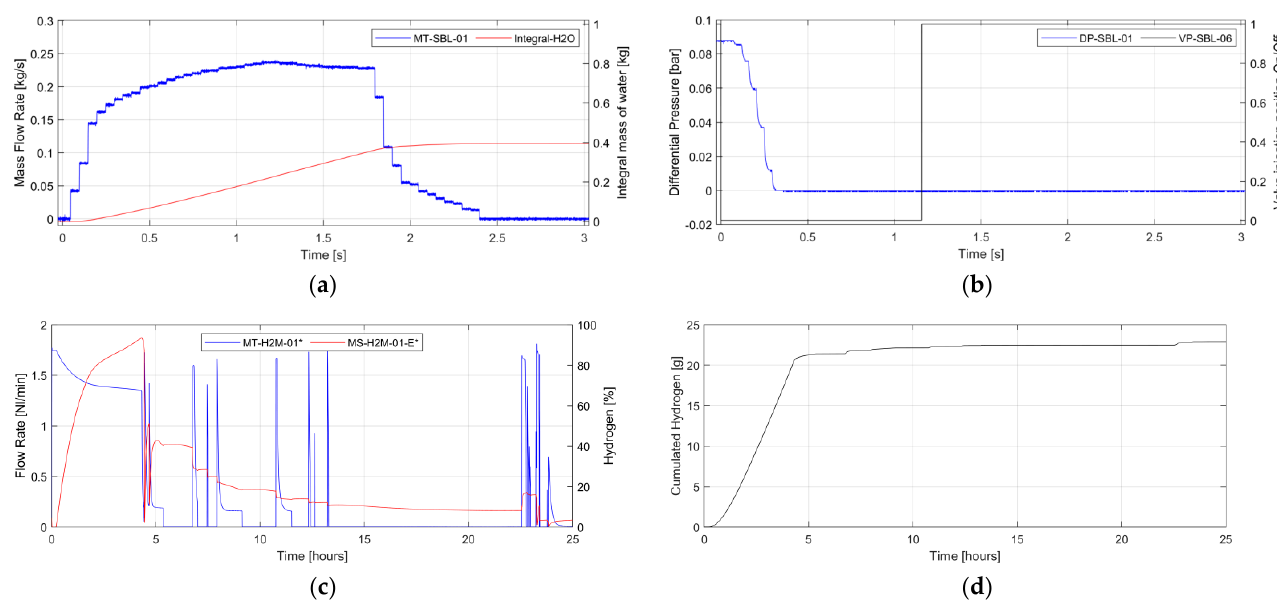
Figure 13. ( a ) Injected water mass flow rate and integral value; ( b ) differential pressure measured in the SBL tank; ( c ) gas mass flow rate (MT-H2M-01) and hydrogen concentration percentage (MS-H2M-01) time trends; ( d ) cumulated hydrogen time trend.